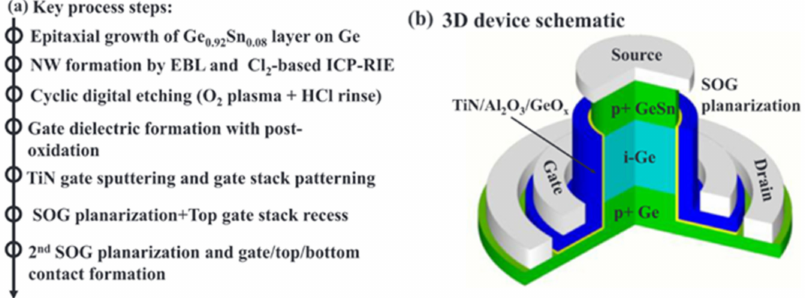
Figure 43. ( a ) Fabrication process and ( b ) 3D schematic of single vertical heterojunction GeSn/Ge GAA nanowire pMOSFETs. Reproduced with permission from [220], Elsevier,